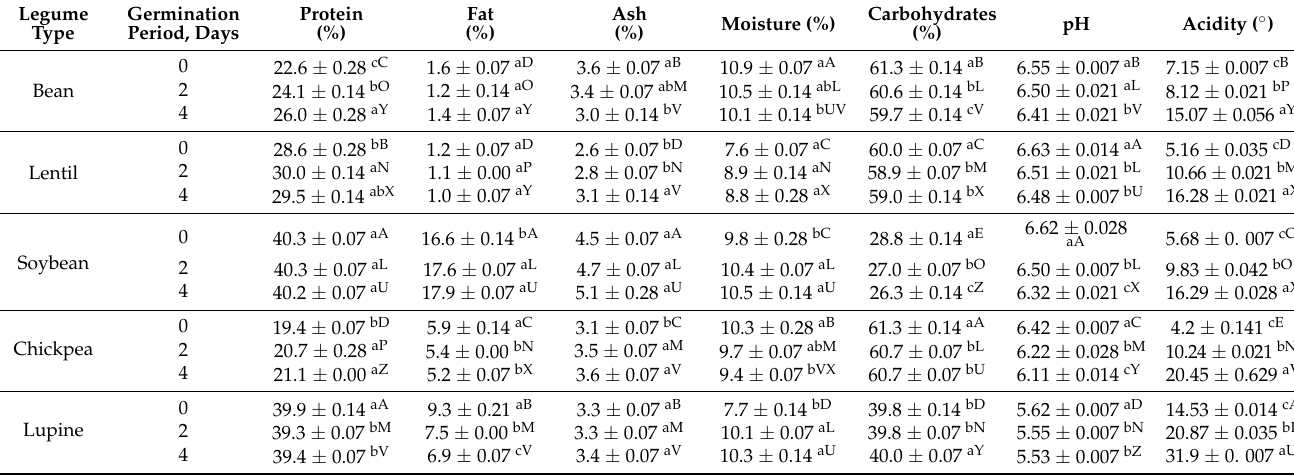
Table 1. Physical-chemical properties of legume seeds during germination